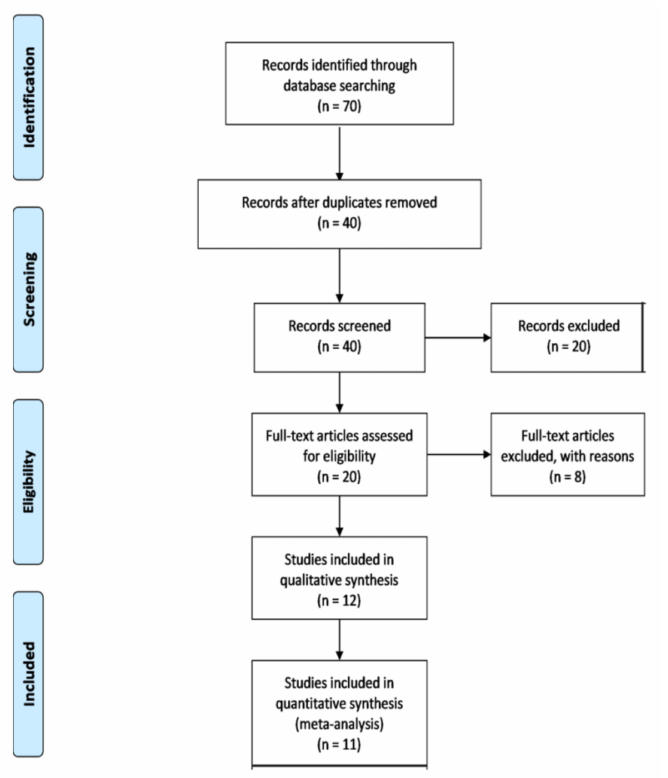
Figure 1. PRISMA flow diagram of the study selection